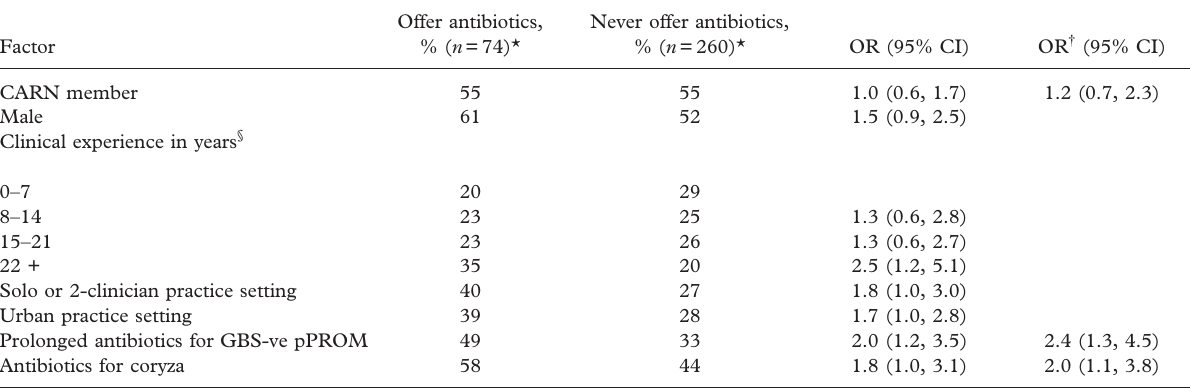
Table I. Factors associated with obstetrician-gynecologists who attempt to eradicate group B streptococcal colonization by prenatal antibiotic therapy